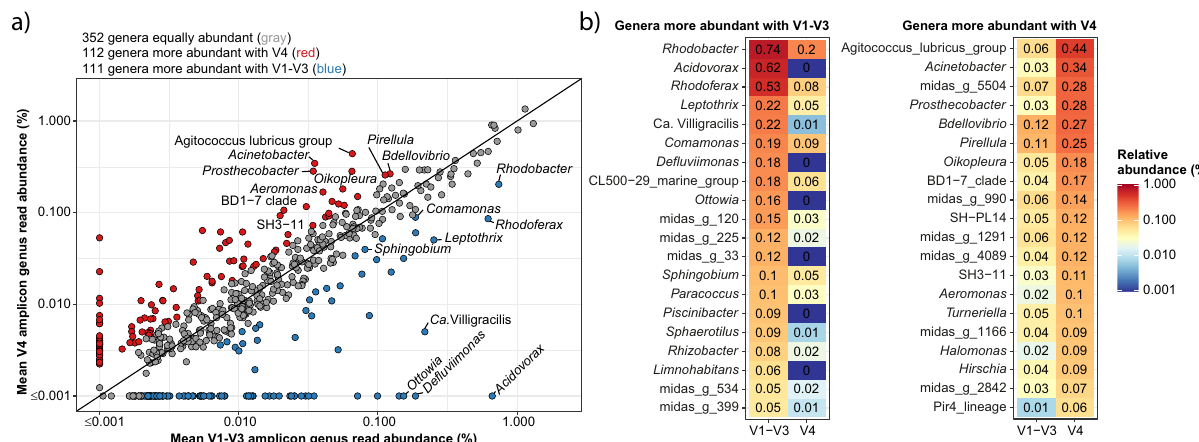
Fig. 4 Comparison of relative genus abundance based on V1 – V3 and V4 region 16S rRNA gene amplicon data. a Mean relative abundance was calculated based on 709 activated sludge samples. Genera present at ≥ 0.001% relative abundance in V1 – V3 and/or V4 datasets are considered. Genera with less than twofold difference in relative abundance between the two primer sets are shown with gray circles, and those that are overrepresented by at least twofold with one of the primer sets are shown in red (V4) and blue (V1 – V3). The twofold difference is an arbitrary choice; however, it relates to the uncertainty we usually encounter in amplicon data. Genus names are shown for all taxa present at a minimum of 0.1% mean relative abundance (excluding those with de novo names). b Heatmaps of the most abundant genera with more than twofold relative abundance difference between the two primer sets.